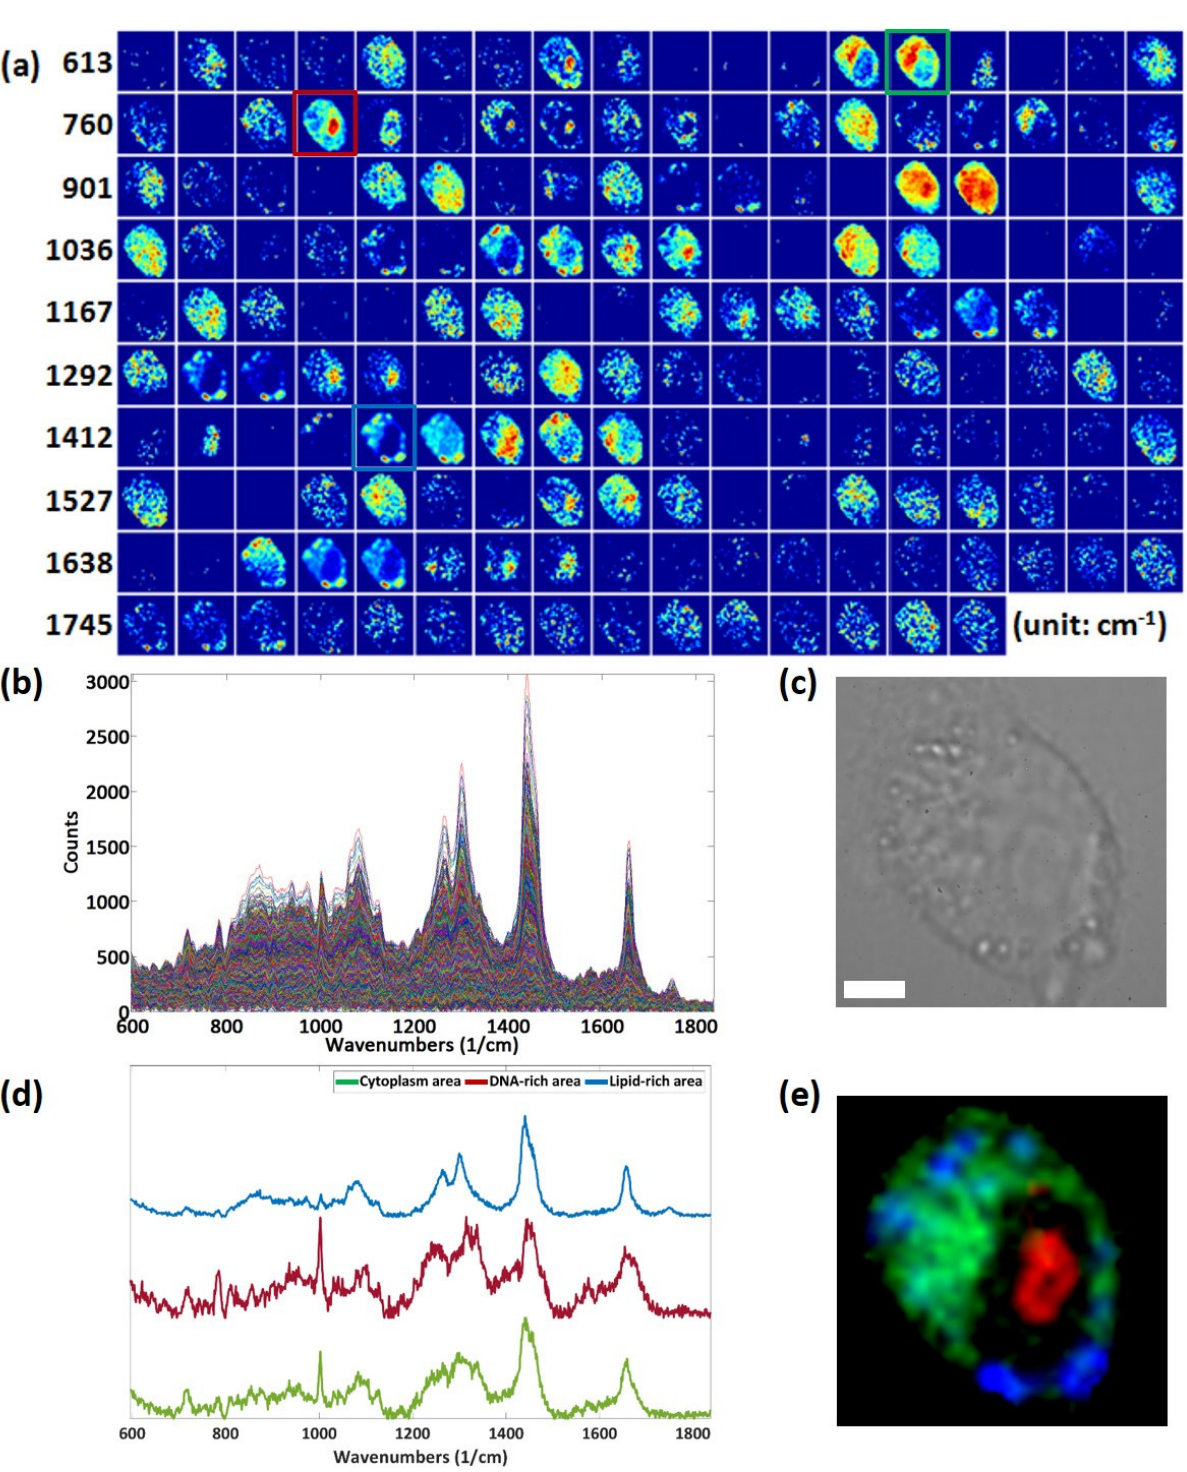
Figure 2. ( a ) Raman images of a live HeLa cell from various Raman bands between 613 cm − 1 and 1825 cm − 1 . Different Raman bands show different distributions throughout the cell. ( b ) A total of 1,600 overlaid Raman spectra (40 × 40 spectra) from a single cell. ( c ) Bright ‐ field image of live HeLa cell used in the experiment. (Scale bar: 5 μ m). ( d ) Representative spectra from cytoplasm, nucleolus, and lipid droplets. ( e ) Pseudo ‐ color image reconstructed from 785 cm − 1 (red), 720 cm − 1 (green), and 1450 cm − 1 (blue) Raman bands.